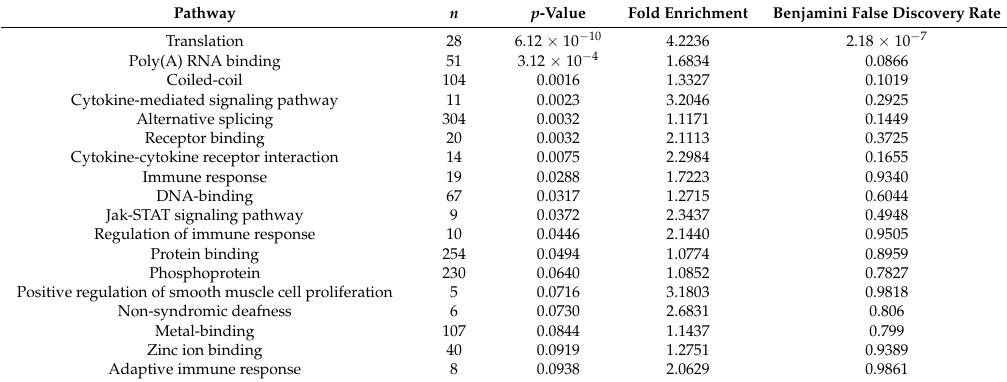
Table 2. Functional annotation clustering of genes differentially expressed in epileptic children.